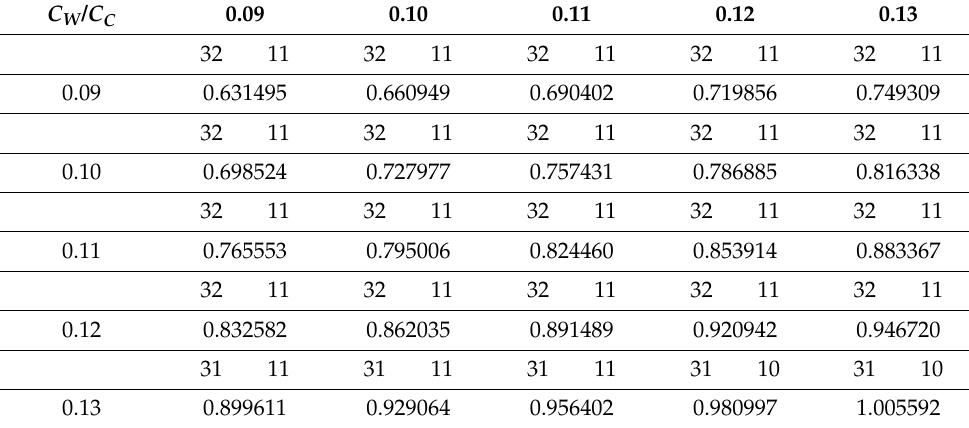
Table 8. Impact of C W and C C costs on the optimal